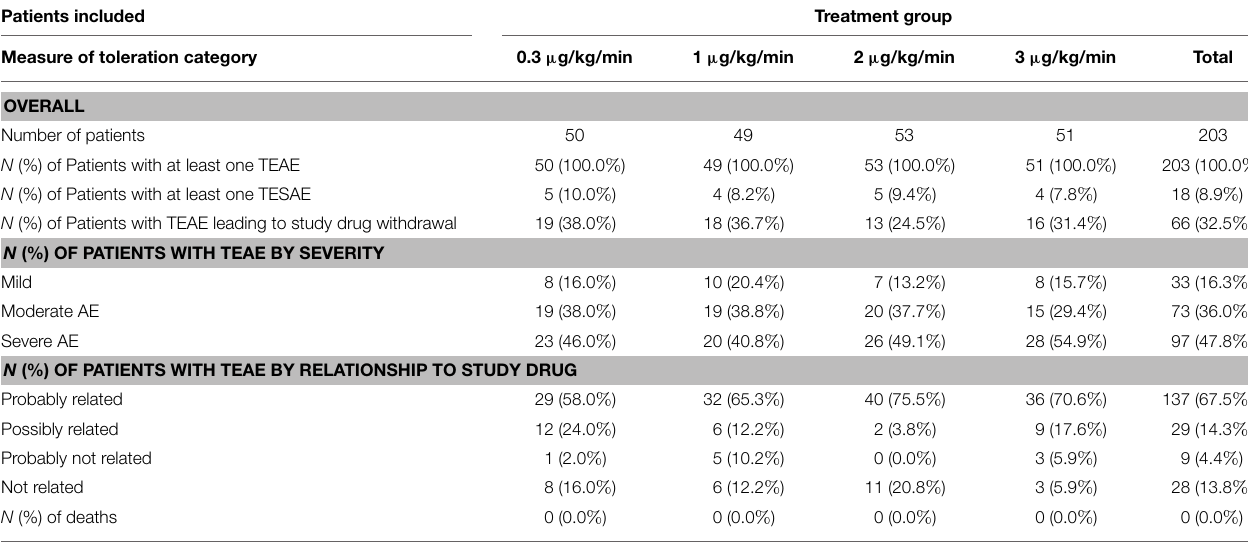
TABLE 4 | Overall summary of tolerability/adverse events for ITT safety population. Patients